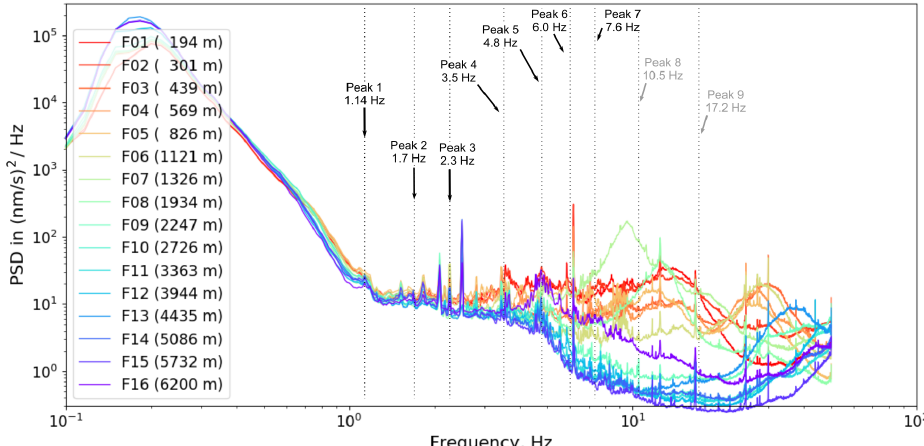
Figure 3. Average PSD spectra at zero power status (0–1rpm), calculated at profile stations F01 to F16 in the time range from September 2019 to March 2020. The identified peaks at full power (Fig. 2) have disappeared. The remaining sharp peaks show no systematic decrease with increasing distance, indicating that they have a different